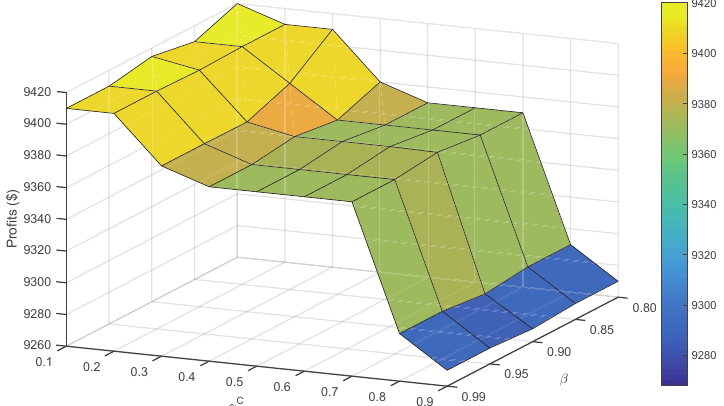
Figure 14. Total profits as a function of β and γ C